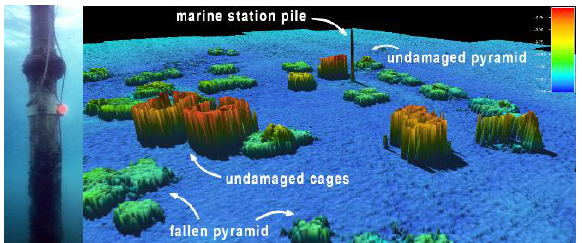
Figure 4. Marine station pile (left) and its 3D model in close-up perspective view of the AR multibeam bathymetry recorded in 2014 (right)